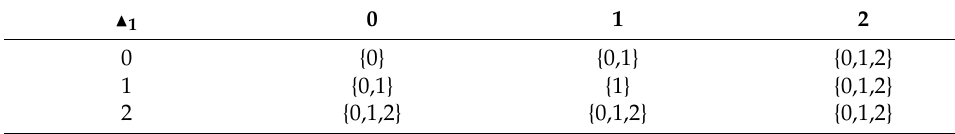
Table 7. The binary hypergroupoid ( C 1 , (cid:78) 1 ).